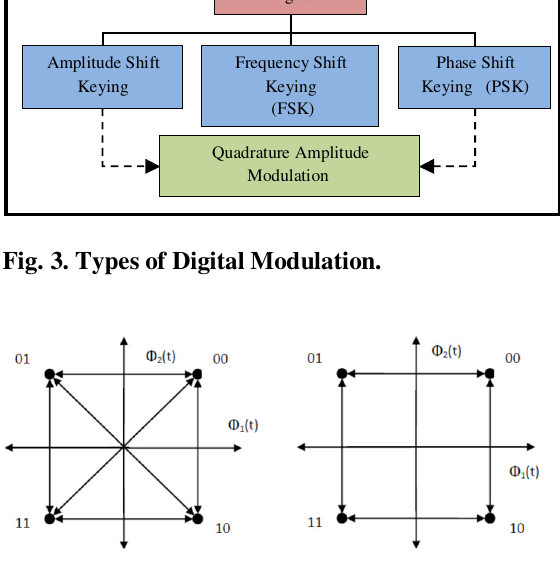
Fig. 4. Constellation Plot of QPSK and OQPSK.